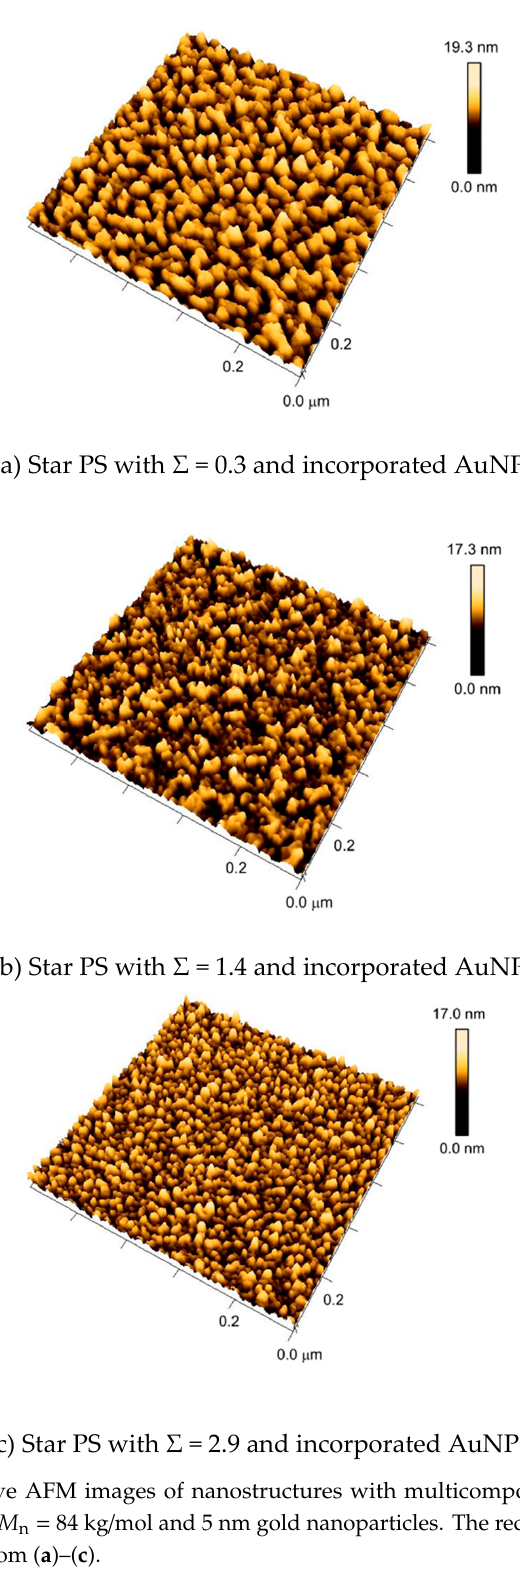
Figure 7. Representative AFM images of nanostructures with multicomponent assemblies of star RAFT polystyrene with M n = 84 kg / mol and 5 nm gold nanoparticles. The reduced grafting density of polystyrene increases from ( a ) to ( c ).